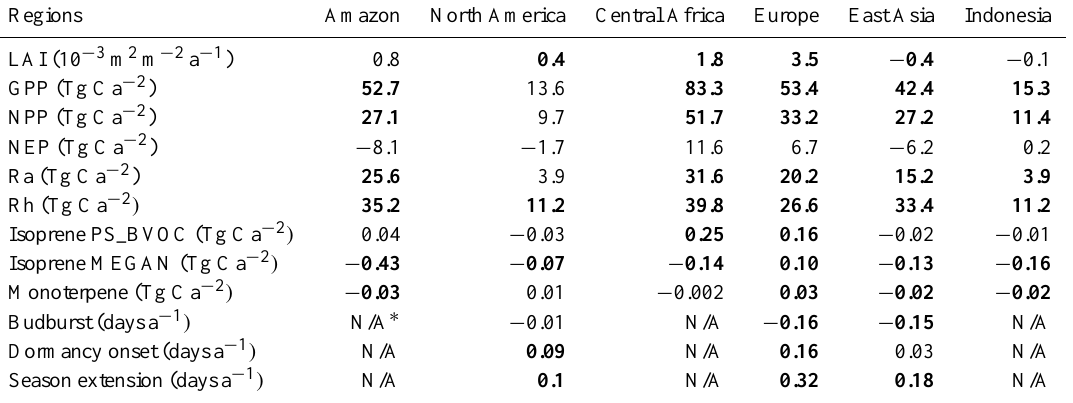
Table 2. Summary of trends in different domains from the simulation CO2_MET_LUC, which is driven with WFDEI meteorology. Signifi- cant trends ( p < 0 . 05) are shown in bold. Regions